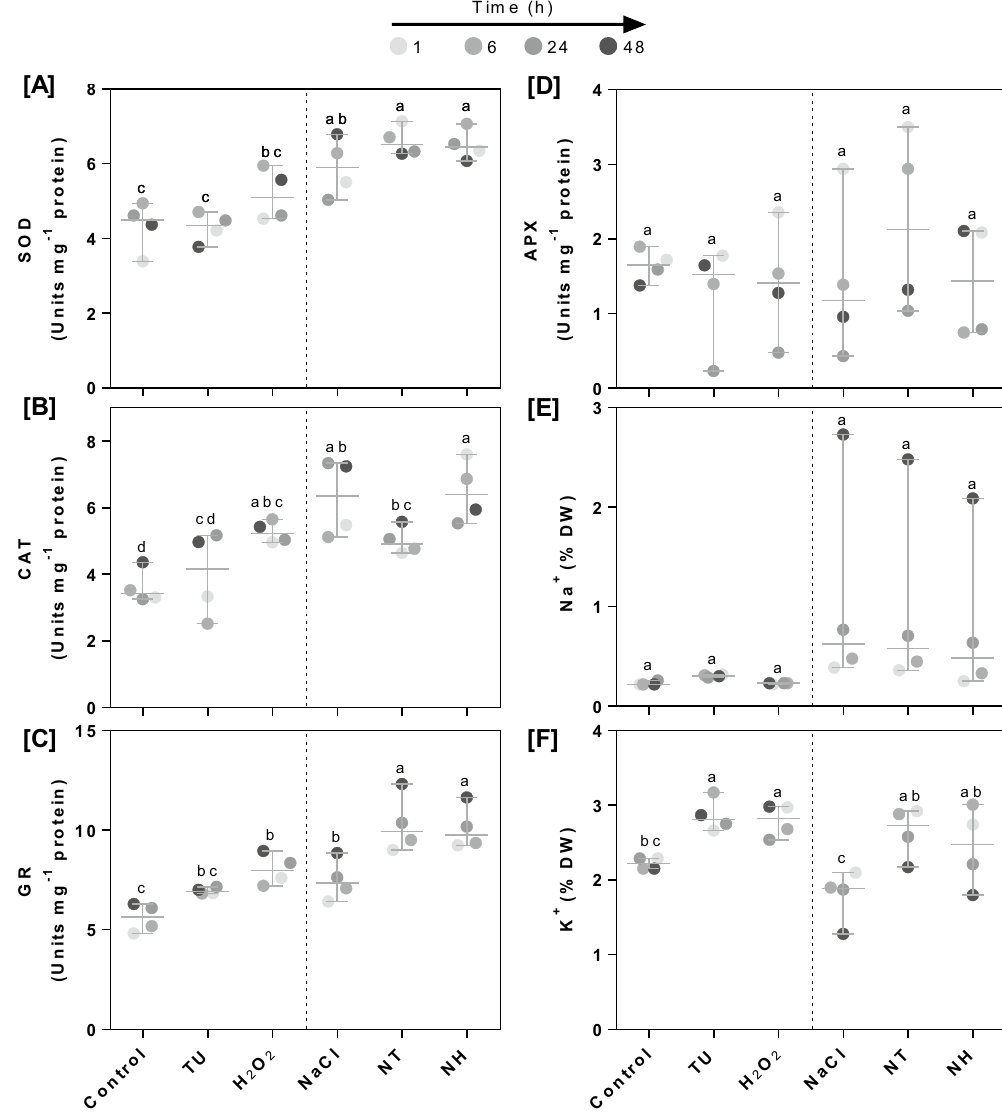
Figure 2. The temporal regulation of antioxidant enzyme activities and levels of Na + and K + in rice seedlings. The rice seedlings were grown hydroponically for 14 days under control conditions and then, subjected to different treatments including control (Yoshida medium), NaCl (50 mM), TU (7.5 µM), NaCl (50 mM) + TU (7.5 µM) [NT], H 2 O 2 (1 µM) and NaCl (50 mM) + H 2 O 2 (1 µM) [NH]. After 1, 6, 24 and 48 h of treatment, the leaf tissue was harvested and analyzed for superoxide dismutase (SOD; A ), catalase (CAT; B ), gutathione reductase (GR; C ) and ascorbate peroxidase (APX; D ), Na + ( E ) and K + ( F ). For NT and NH, 24 h pretreatment of 7.5 µM TU and 1 µM H 2 O 2 respectively was also given. The data represented in the form of median value with range was computed using individual data from all four time-points (1, 6, 24 and 48 h). Refer supplementary table 2 for statistics of individual time point. Different letters indicate significantly different values (DMRT, p ≤